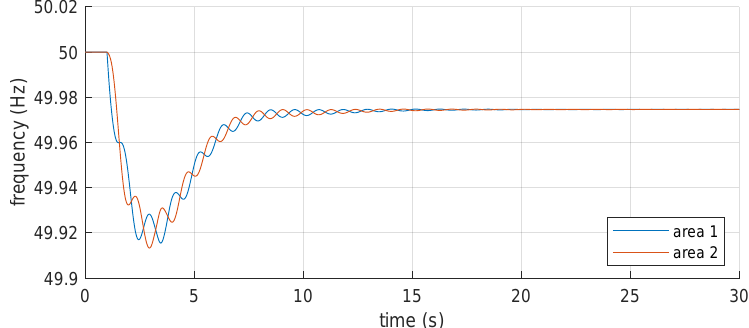
Figure 9. All synchronous generation.